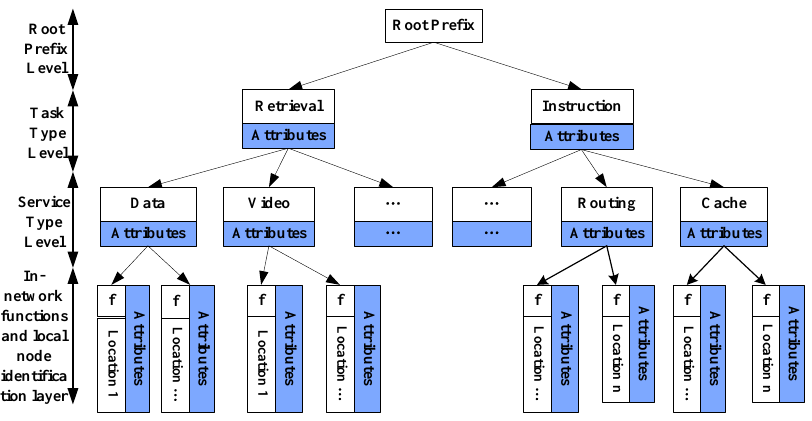
Figure 11. Multilayer multicomponent names designed for ICN-HMcH.